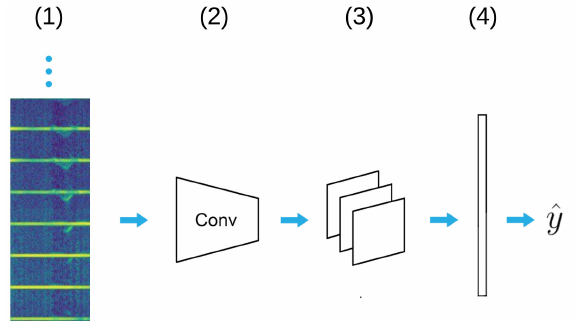
Figure 4. A spectrogram image (1) is processed with a stack of 32 × 64 × 128 × 256 convolutional layers with 3 × 3 kernel to capture spatial information. Each convolutional layer extracts feature maps from the input image and is further processed by maxpooling layer (3). Finally, a softmax layer outputs the gesture class prediction ( ˆ y ).